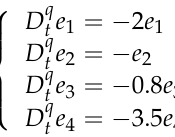
Figure 10. Time series of the drive supply chain system (12) (blue line) and the response supply chain system (13) (red dot line) when 0.75 q = , and 0.7 d = .